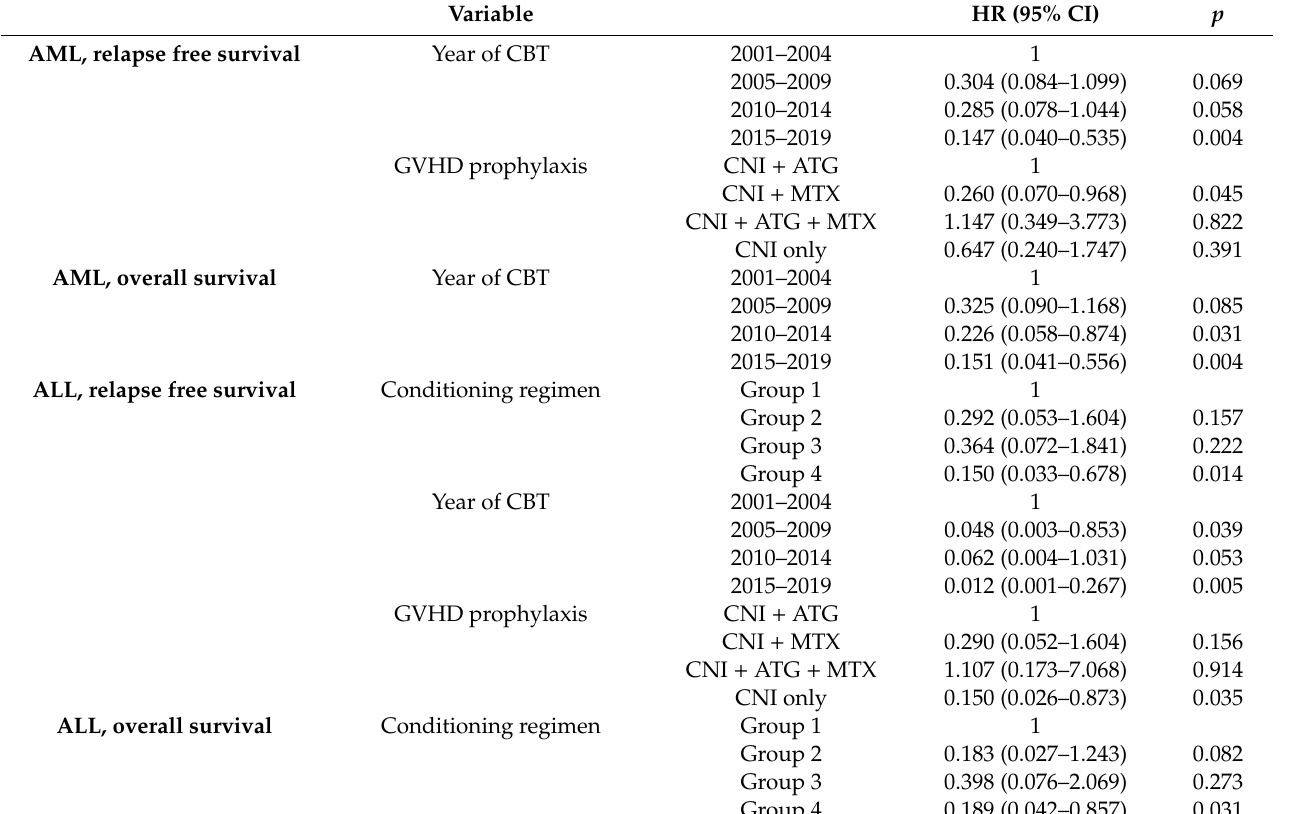
Table 3. Risk factors for transplantation outcomes on multivariate